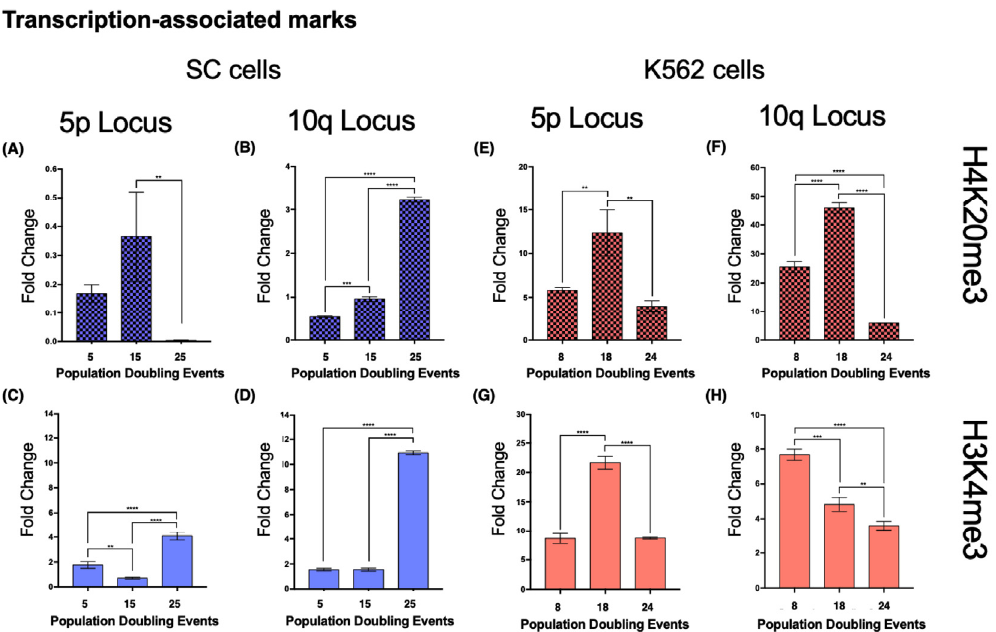
Figure 9. Antagonizing histone marks occurring in the same locus favored TERRA transcription.